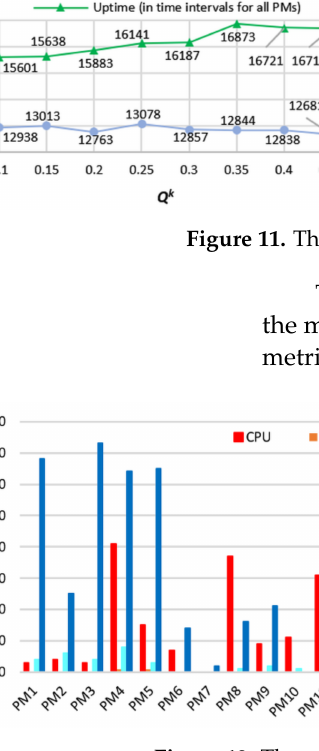
Figure 12. The quality metrics of the SLA violation minimization after a simulation